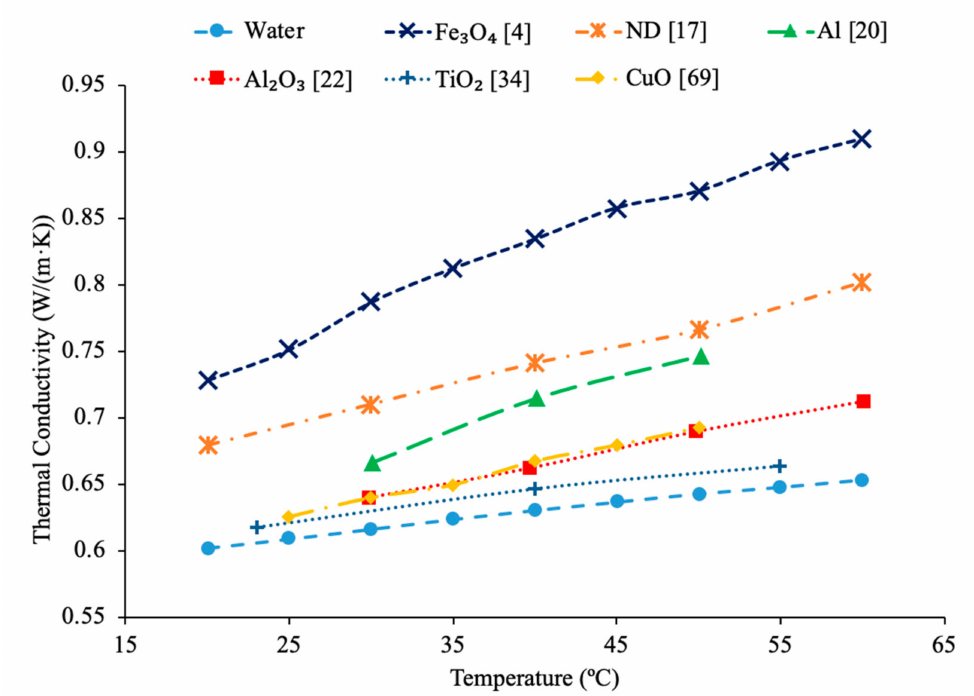
Figure 29. Thermal conductivity of CuO, Al 2 O 3 , Fe 3 O 4 , Al, TiO 2 and ND water-based nanofluid as a function of temperature at a volume concentration of 1%